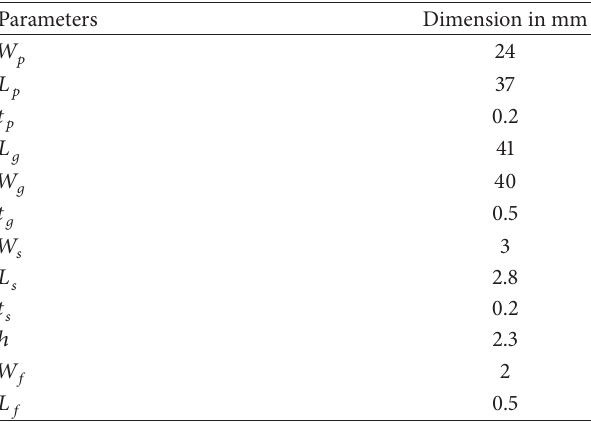
Table 1: Antenna parameter’s